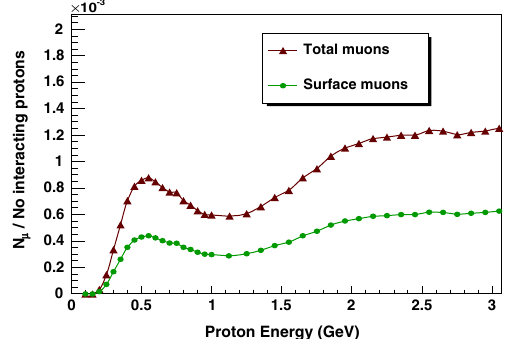
FIG. 11. Variation of muon yield with proton energy.